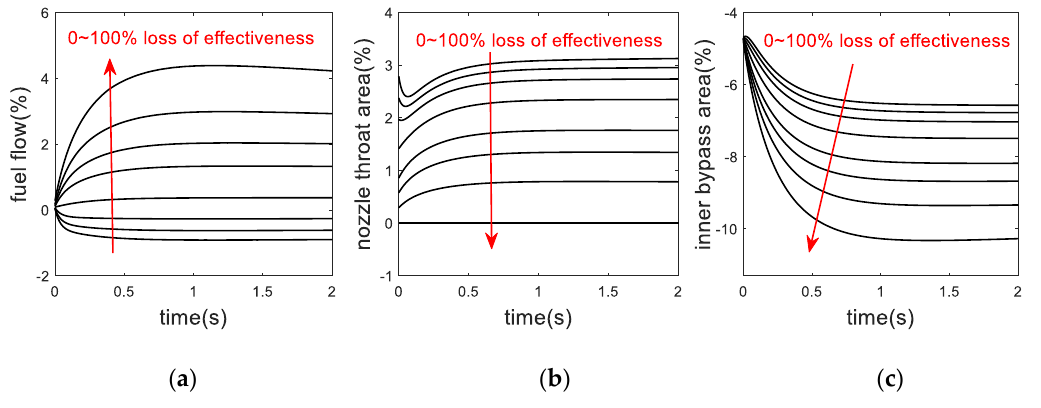
Figure 9. FTC result of ASMC design-control variables. ( a ) W f ( b ) A 8 ( c ) A 125 .